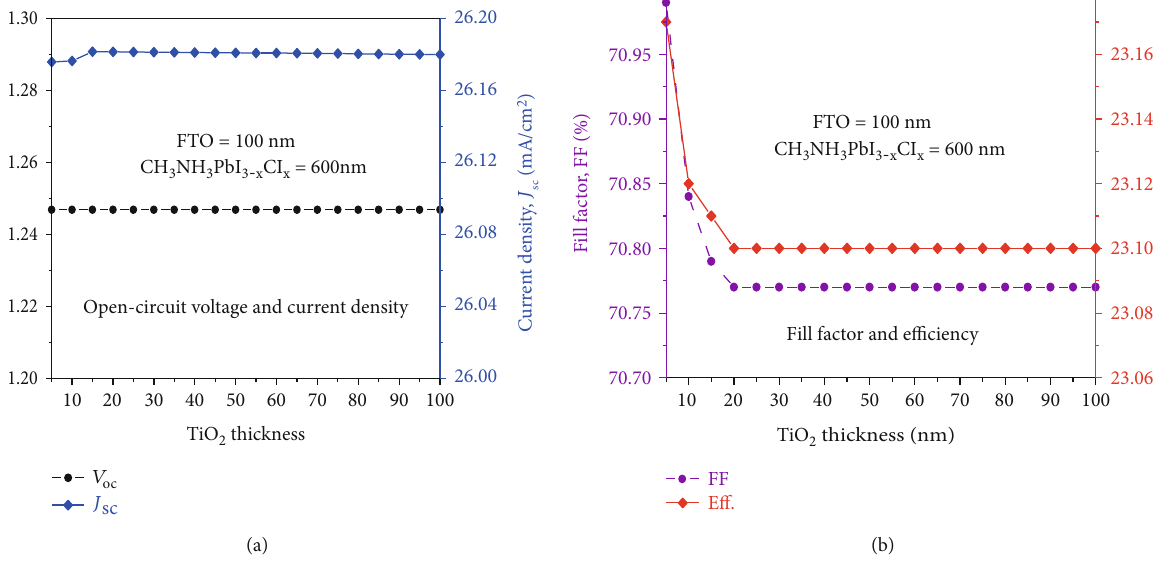
thicknessforconstantFTO andCH